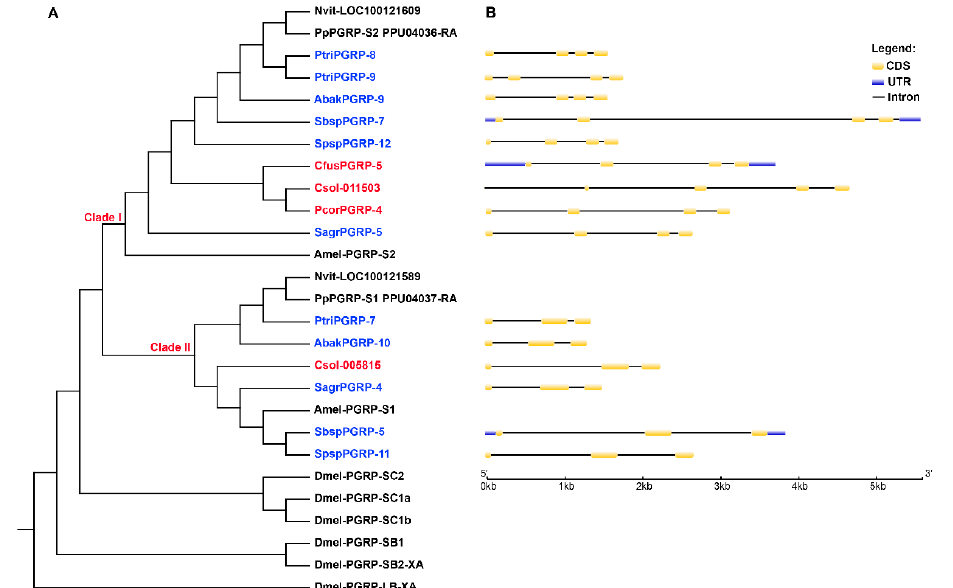
Figure 3. A gene tree of the catalytic PGRP genes ( A ) and their gene structures ( B ). ( A ) In the tree, the catalytic PGRPs of wasps were located on two clades of Clade I and Clade II. All of the five non-pollinator species had at least two catalytic PGRP gene members located on each clade, while only three of the studied seven pollinator species had catalytic PGRP genes. The red gene names represented pollinators, and blue represented non-pollinators. All of the catalytic PGRPs amino acid sequences from D. melanogaster (Dmel-), A. mellifera (Amel-), N. vitripennis (Nvit-), P. puparum (Pp) and the 12 fig wasps were used for Maximum Likelihood (ML) tree construction, with the model of WAG + I + G4. ( B ) Most of the catalytic PGRP genes in Clade I had four exons, while those in Clade II had three. Only catalytic PGRPs from the fig wasps were used to draw the gene